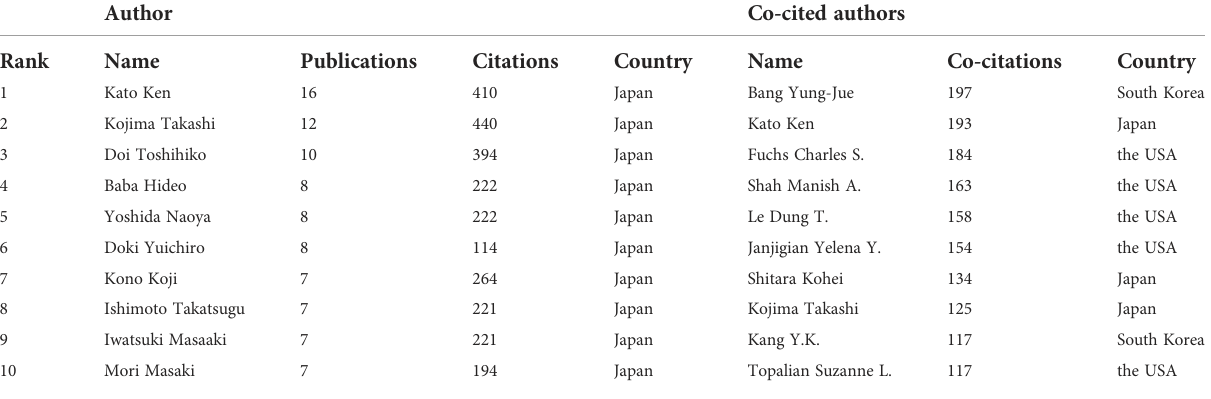
TABLE 4 The top 10 proli fi c authors and co-cited authors on anti-PD-1/PD-L1 immunotherapy for esophageal cancer research from 2012 to 2021.